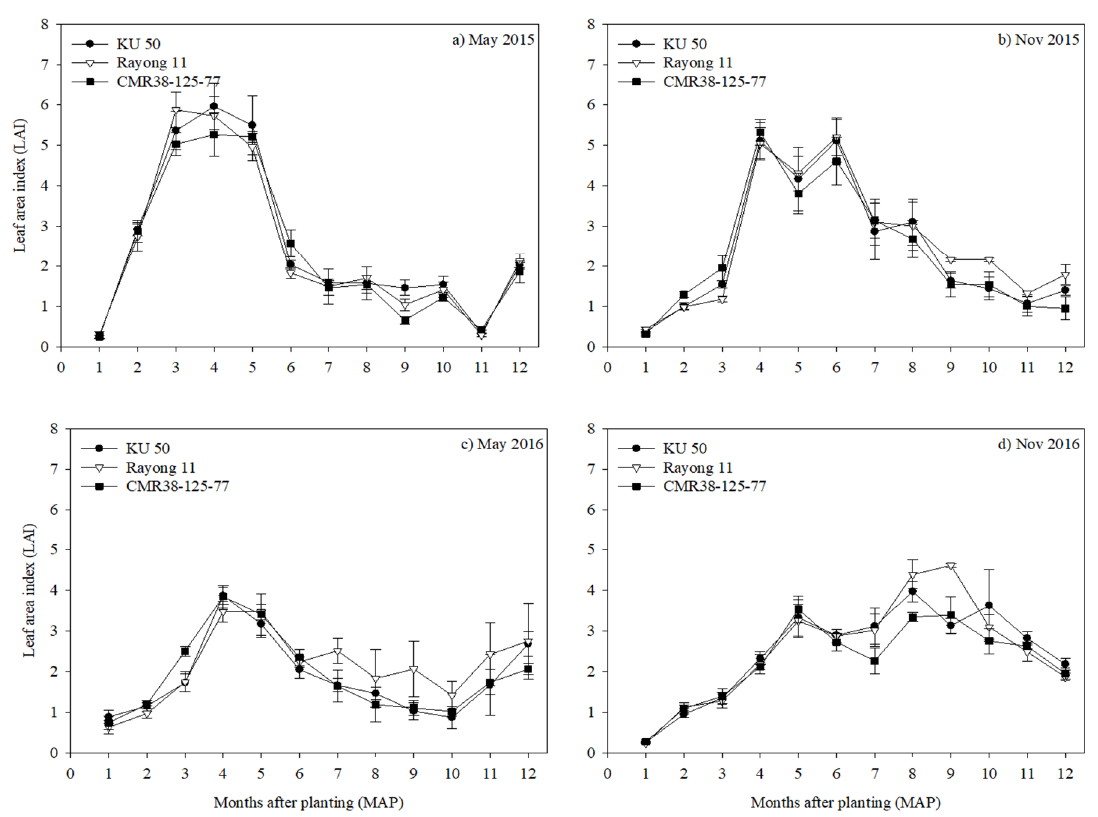
Figure 4. Leaf area index of three cassava genotypes when planted in May ( a ) and November ( b ) 2015 and May ( c ) and November ( d ) 2016. The bars indicate standard deviation of means.